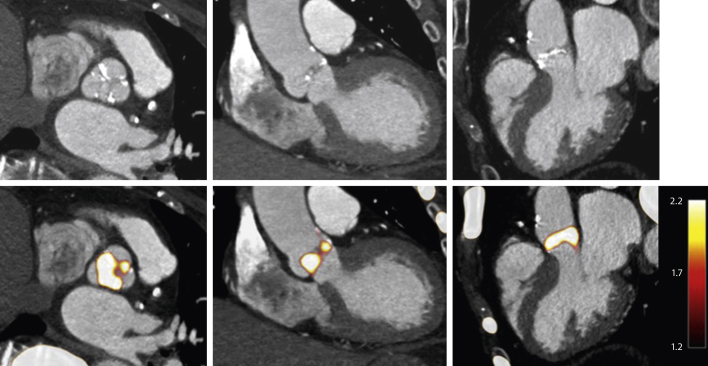
18F-NaF PET-CT of the Aortic ValveContrast-enhanced computed tomography (CT) of the aortic valve (top) with fused radiolabeled sodium fluoride (18F-NaF) positron emission tomography (PET)–CT angiography images in the same patient (bottom). Strong PET uptake can be localized to the aortic valve in short-axis (left), coronal (middle), and sagittal (right) views.